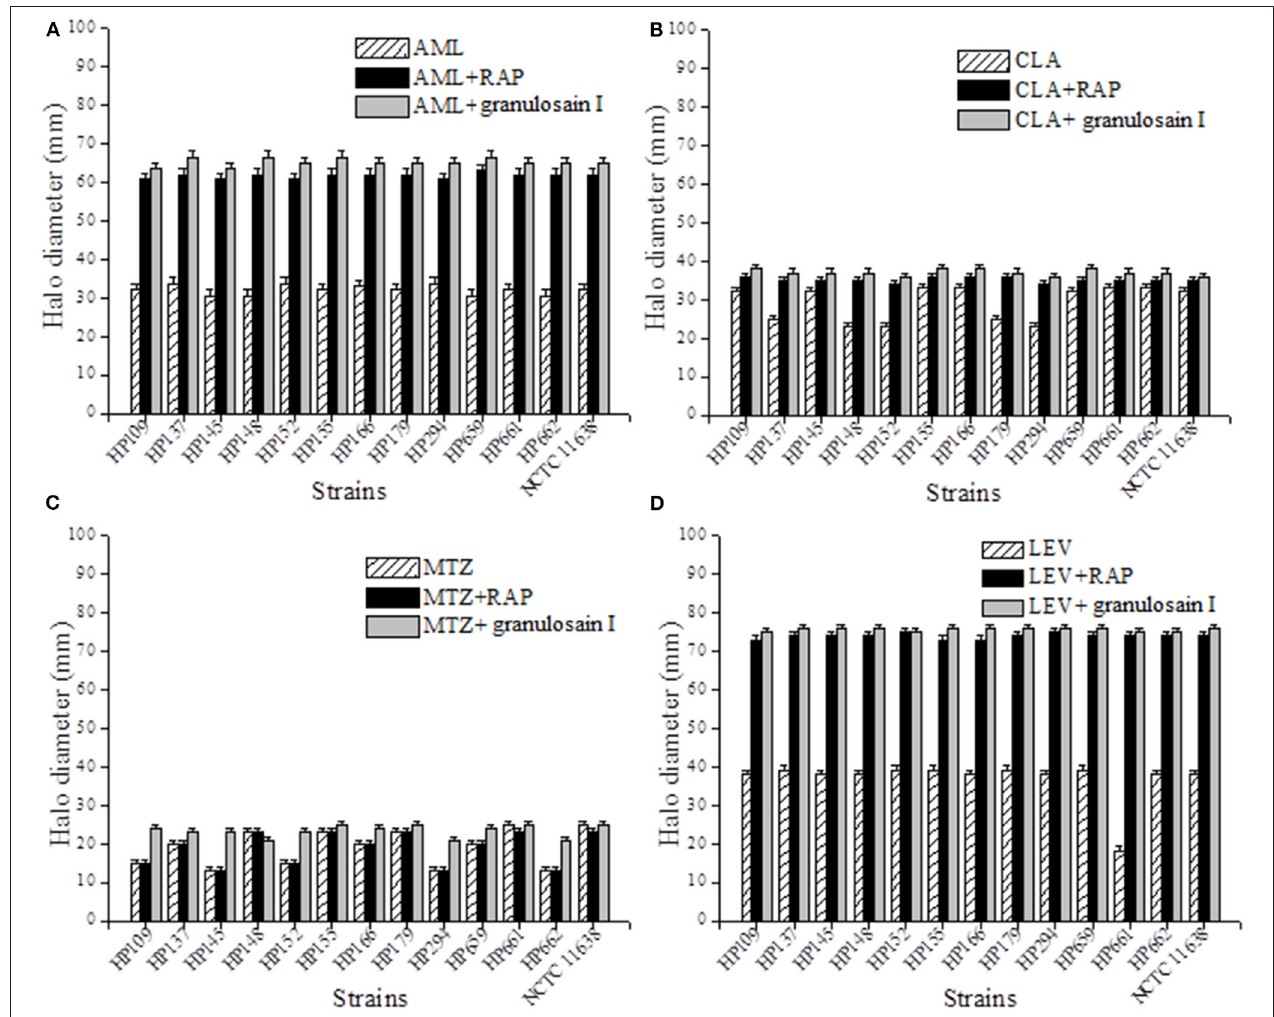
FIGURE 3 | Synergistic effect against Helicobacter pylori after combining the partially purified proteolytic extract (RAP) of the fruits of Solanum granuloso-leprosum or granulosain I and antibiotics such as (A) AML, (B) CLA, (C) LEV and (D)